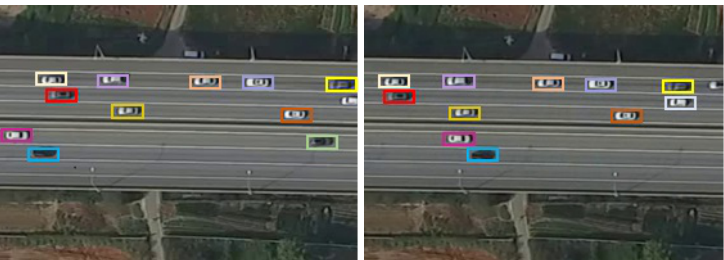
Figure 4. Result of tracking the identical vehicles at 20 s intervals using SORT.